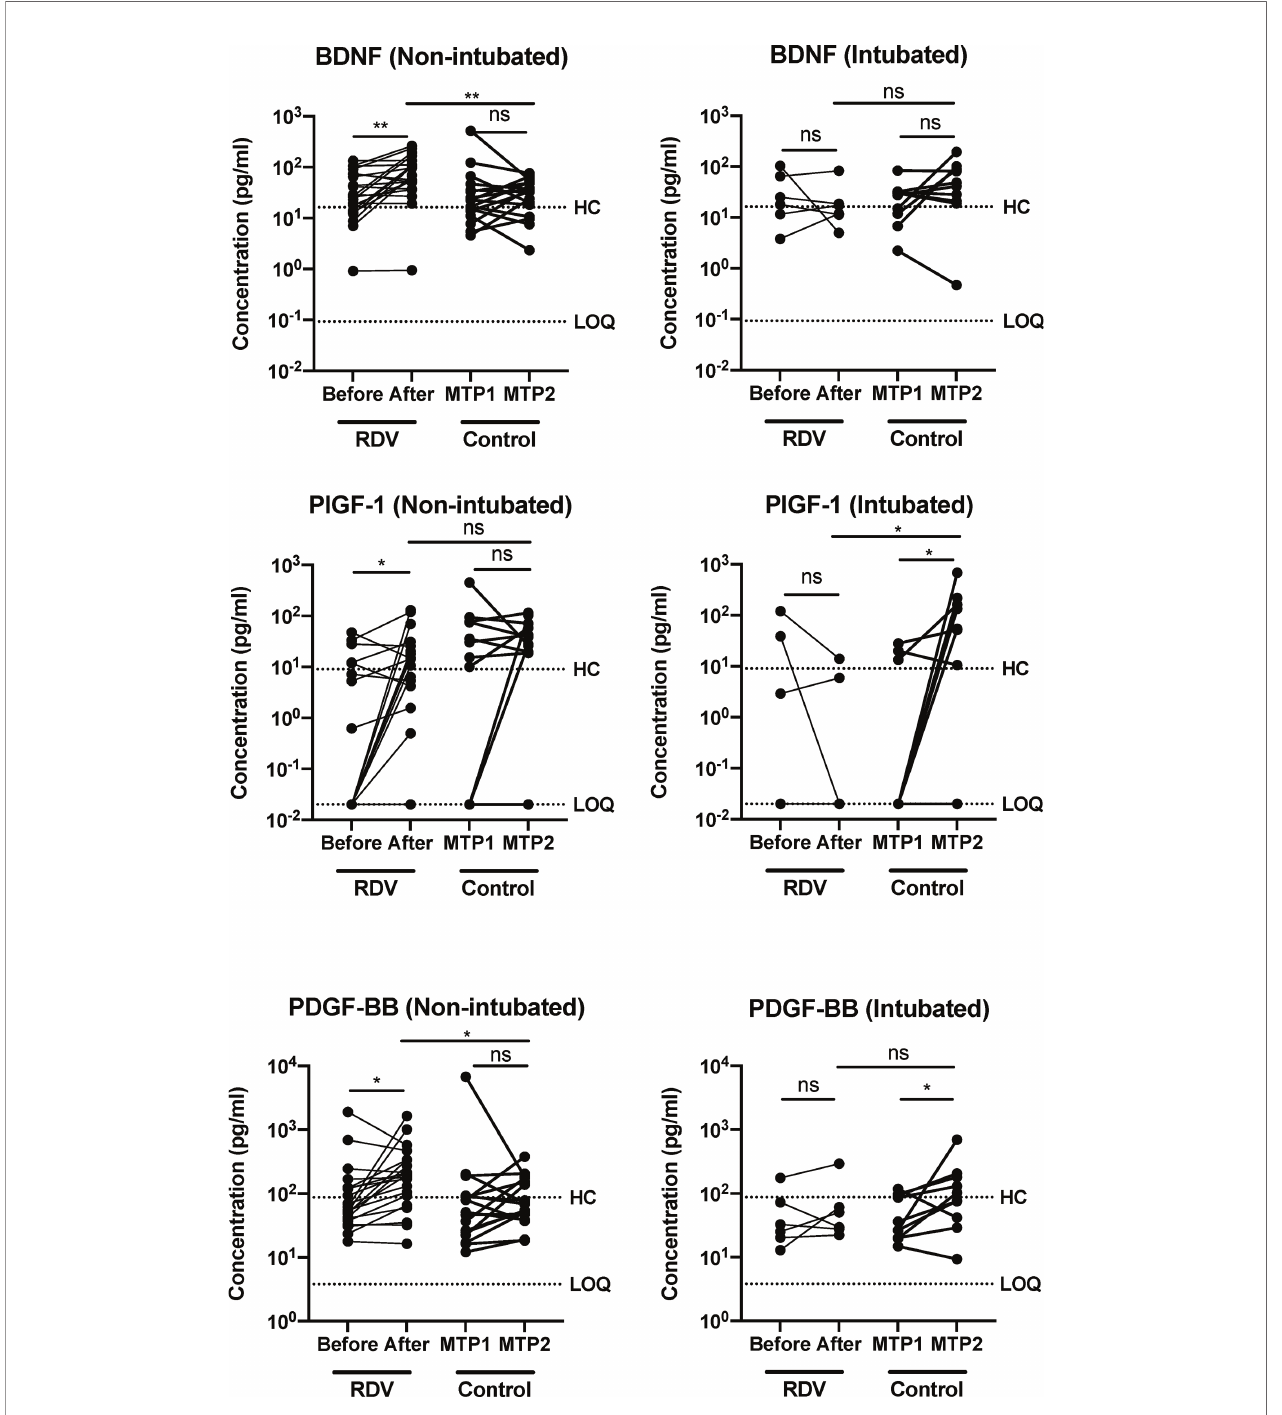
FIGURE 2 | COVID-19 patients responding to remdesivir (RDV) treatment show up-regulation of recovery-associated immune mediators. Growth factors brain-derived neurotropic factor (BDNF), placental growth factor (PIGF-1) and platelet-derived growth factor BB subunit (PDGF-BB) levels in plasma before and after RDV treatment in non-intubated responders (n = 21, median 9 and 16 days post-illness onset (PIO), respectively) and intubated non-responders (n = 6, median 7 and 13 days PIO, respectively), and matched timepoint 1 and 2 in non-RDV-treated non-intubated (n = 17, median 10 and 16 days PIO, respectively) and intubated (n = 10, median 6 and 12 days PIO, respectively) controls. Statistical analyses were performed with Wilcoxon matched-pairs signed rank test when comparing between timepoints, and Mann Whitney U test when comparing across groups (ns, not signi fi cant. * P < 0.05; ** P < 0.01). Immune mediator levels for healthy controls (n=23) are indicated by the black dotted line. Patient samples with concentration out of measurement range are presented as the value of Limit of Quanti fi cation